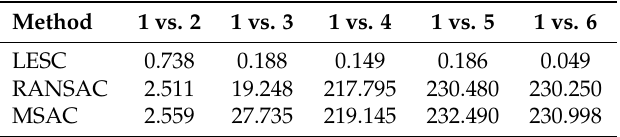
Table 10. The computation time (in seconds) of LESC, RANSAC and MSAC respectively on the Graffiti sequence using the 1st image versus the rest of